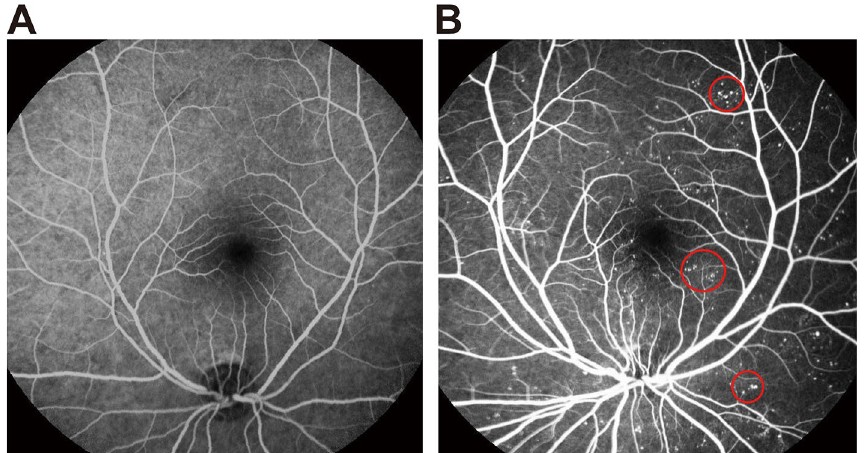
Figure 1. Normal FFA image and FFA image with Mas. ( A ) Normal FFA image; ( B ) FFA image with